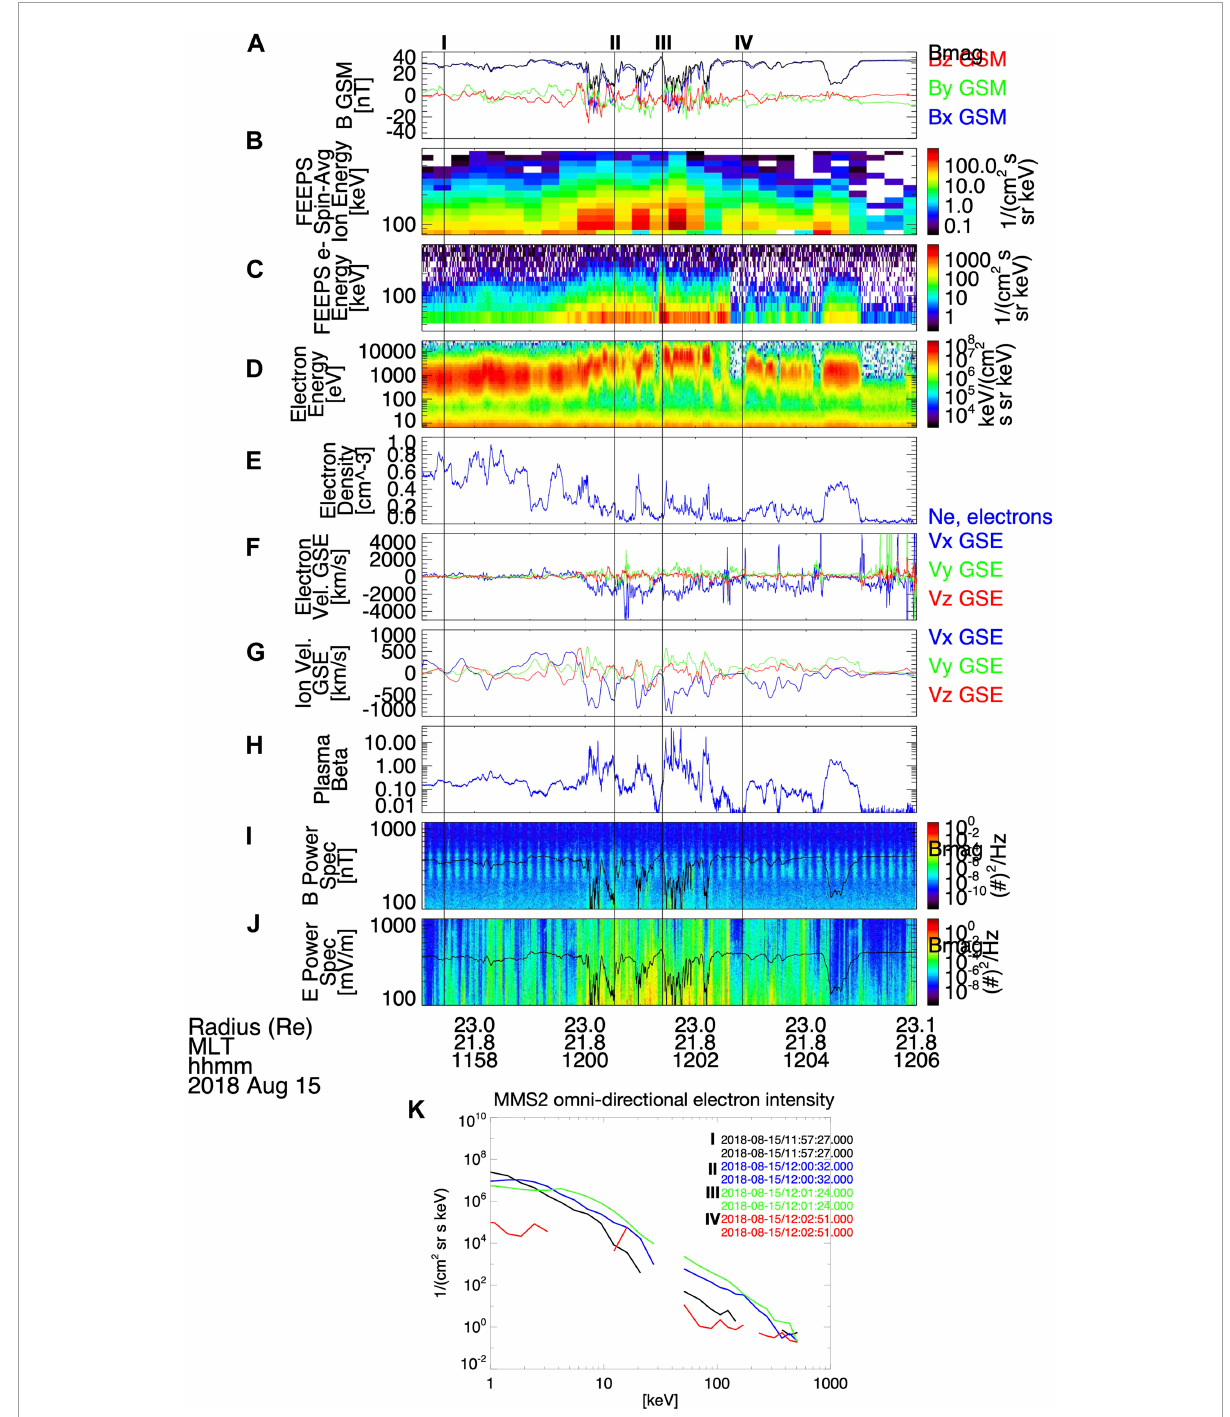
FIGURE 1 Data from MMS for the 15 August 2018 case study. (A) Magnetic field, (B) Spin-averaged FEEPS energetic ion flux, (C) FEEPS energetic electron flux, (D) FPI thermal electron flux, (E) Electron density, (F) Electron velocity, (G) Ion velocity, (H) Plasma beta, (I) Magnetic field power spectrum, (J) Electric field power spectrum. Below the MMS data, (K) are overlayed electron energy spectra from both the FEEPS and FPI instruments taken at a single moment at select times indicated by the vertical lines in the data: one before the energetic electron event (I), two during (II and III), and one after (IV).